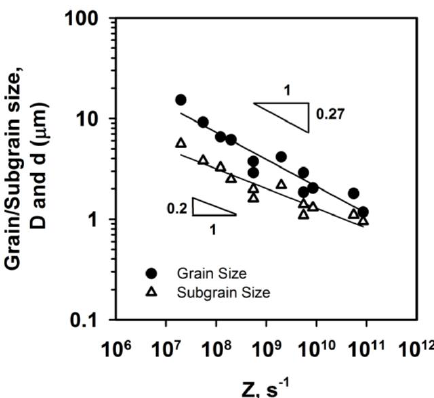
Figure 7. Dependences of the DRX grain/subgrain sizes on the temperature-compensated strain rate ( Z ) for the high nitrogen austenitic stainless steel.